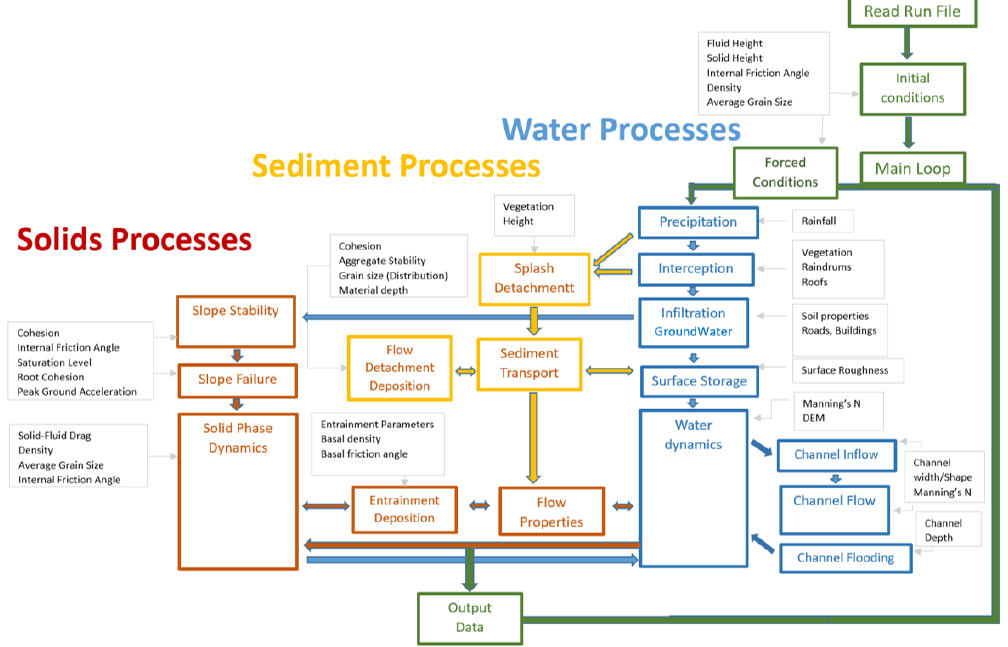
Figure 3. A schematic overview of the OpenLISEM Hazard model, including the link with the most relevant input